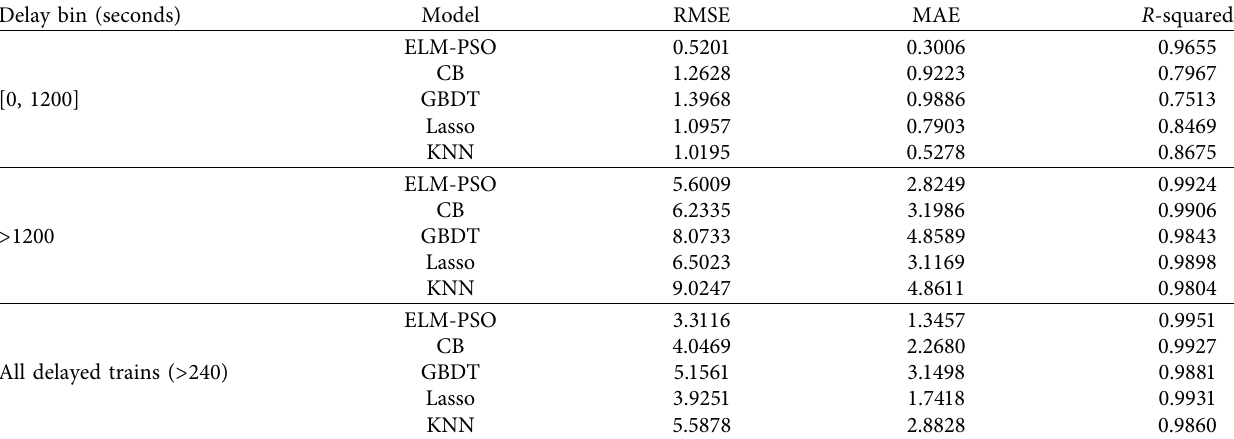
Table 5: Model performance comparison on test set for the five models for different delay bins.